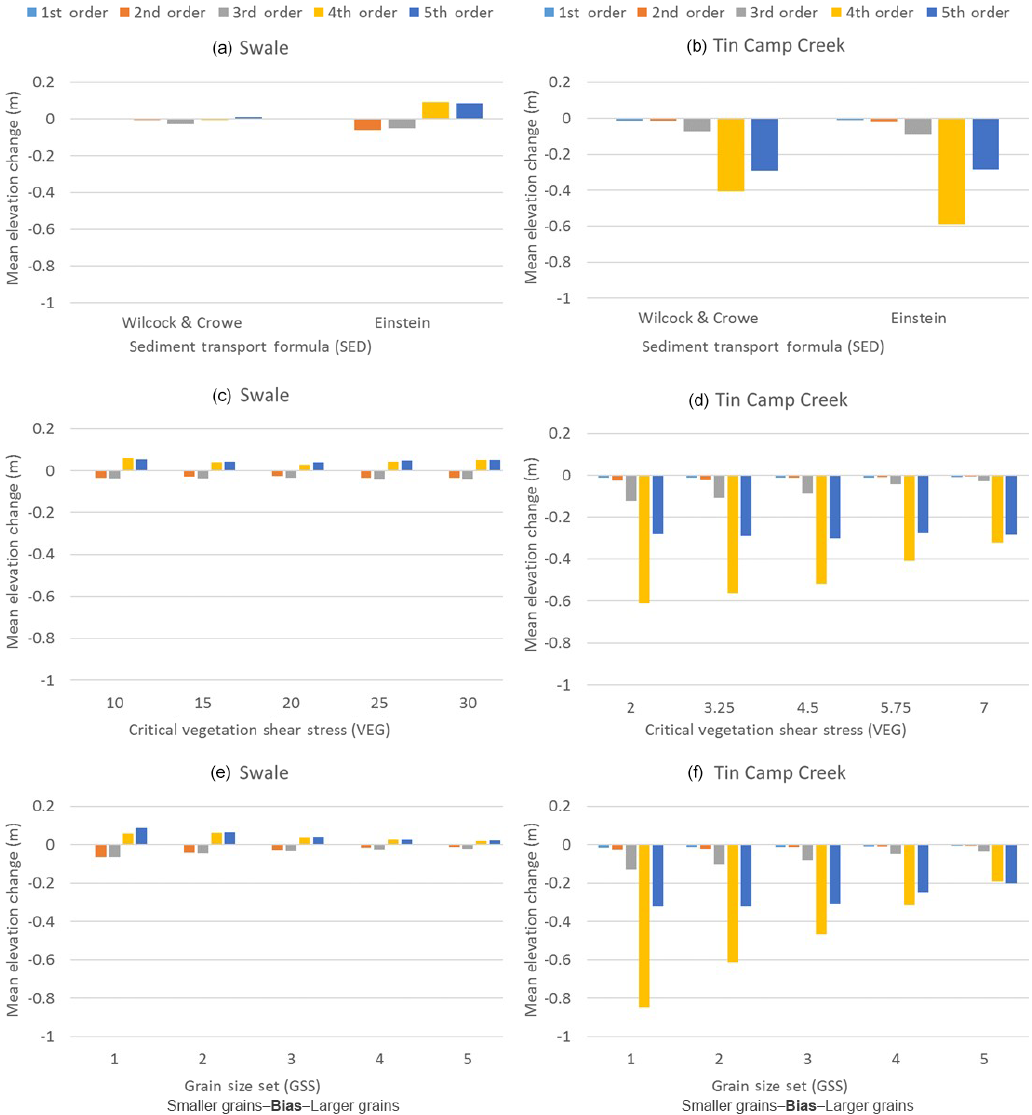
Figure 5. Illustration of changes in the mean elevations for Upper Swale (a, c, e) and Tin Camp Creek (b, d, f) for the tests split by SED (a, b) , VEG (c, d) , and GSS (e, f) where 1 and 2 are biased smaller, and 4 and 5 are biased larger. The catchment is subdivided into watersheds of five stream orders, based on proportion of catchment